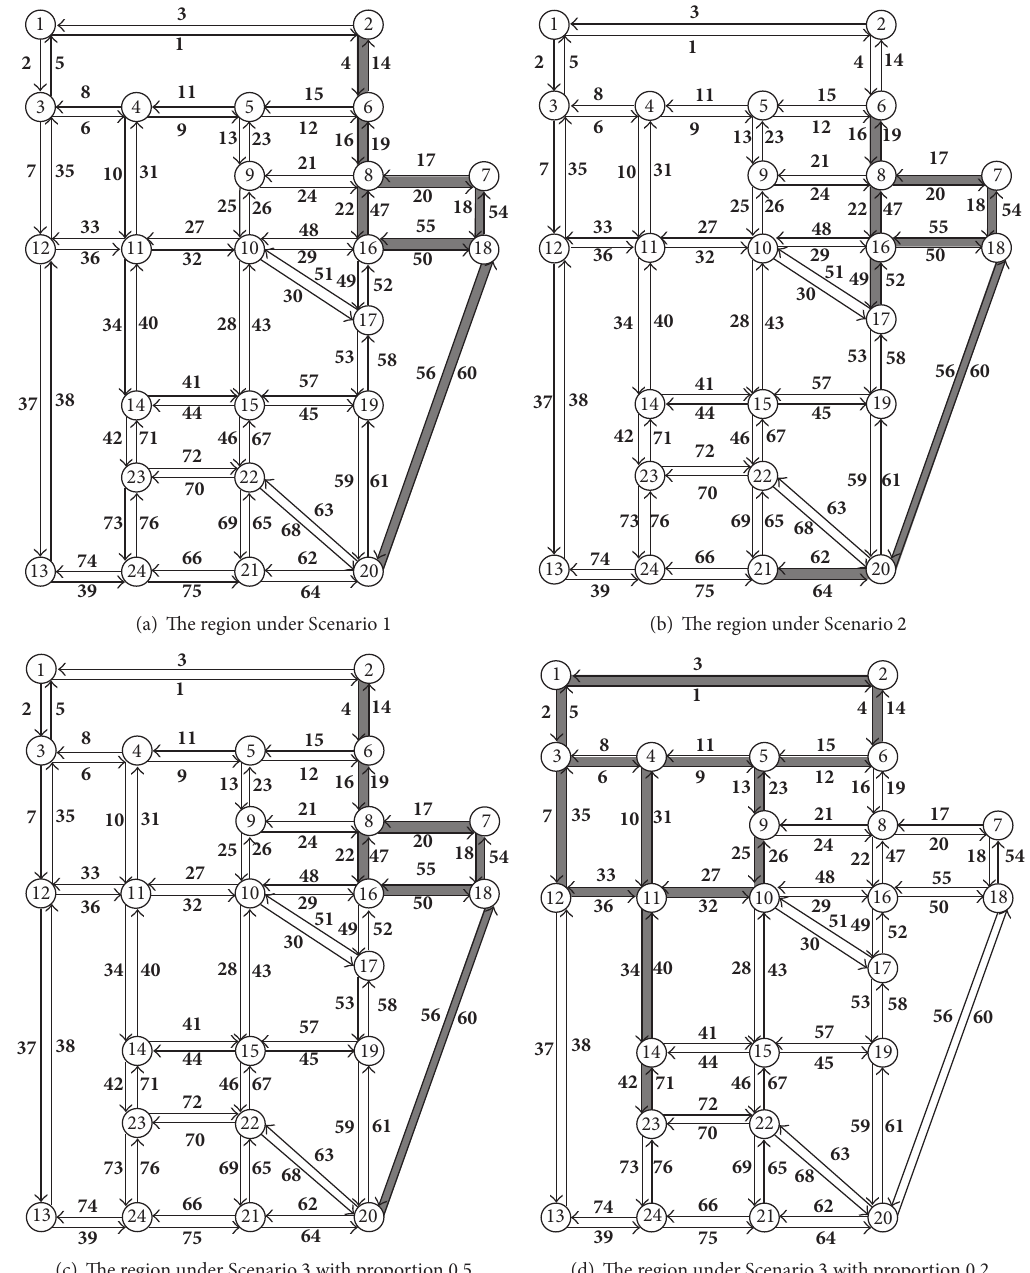
Figure 4: The traffic restriction regions under various